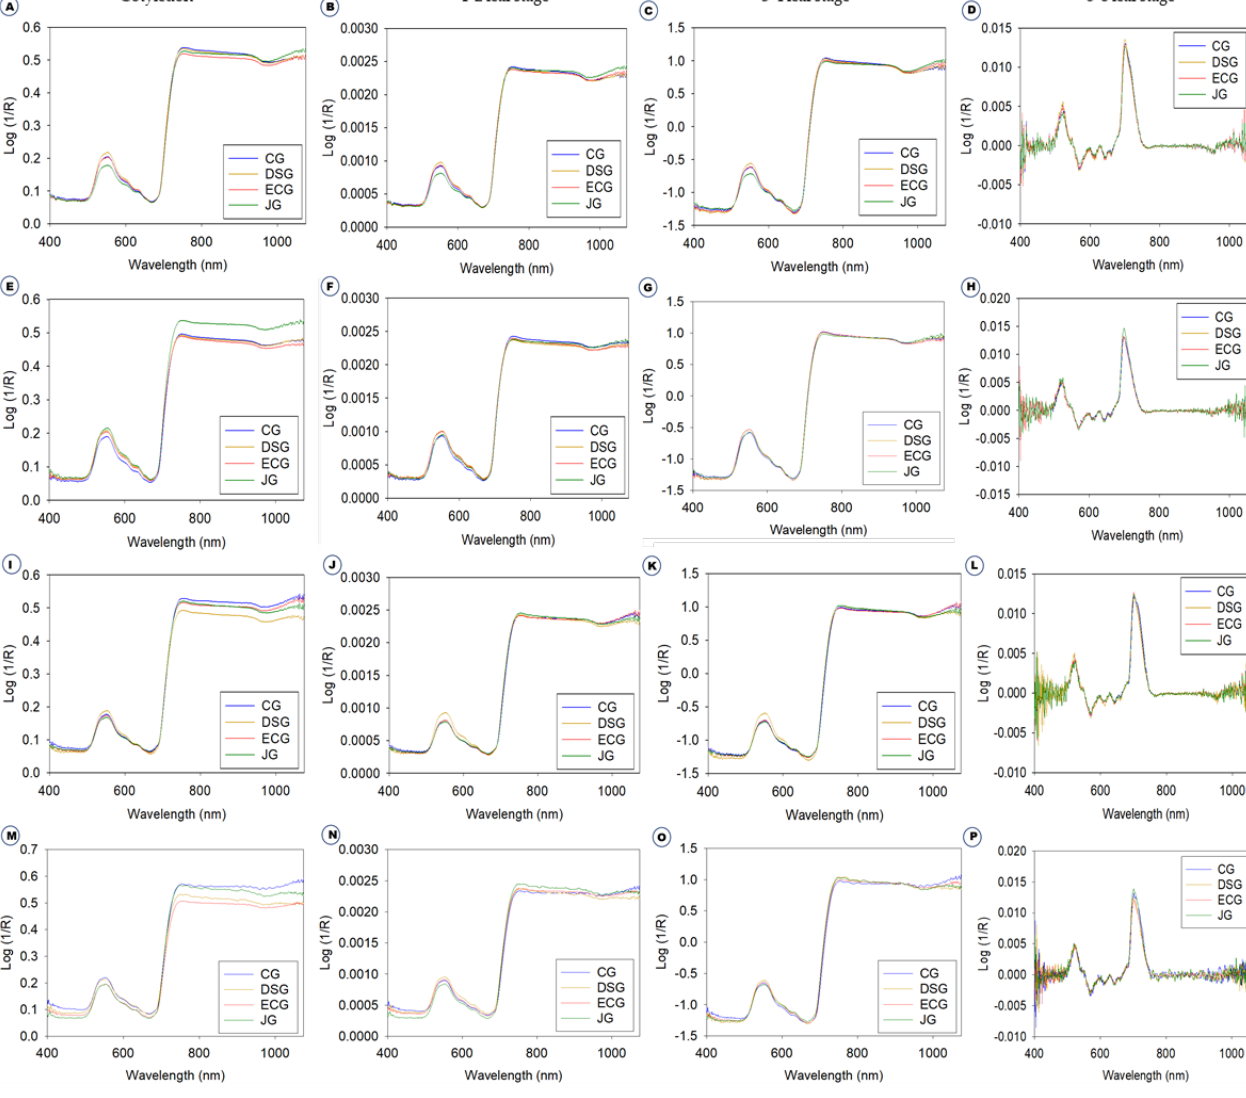
Figure 1. Average raw and preprocessed spectra of four growth stages of four B. juncea varieties. Average raw ( A , E , I , M ) and preprocessed with different preprocessing methods, namely, normalization ( B , F , J , N ), standard normal variate ( C , G , K , O ), and Savitzky – Golay ( D , H , L , P ).